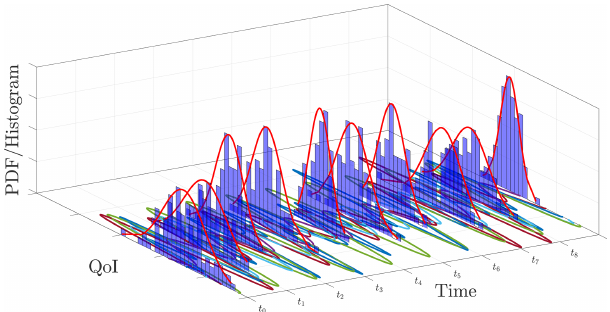
Figure 2. A schematic drawing presenting possible distributions at each time step based on a set of time trajectories for a quantity of interest